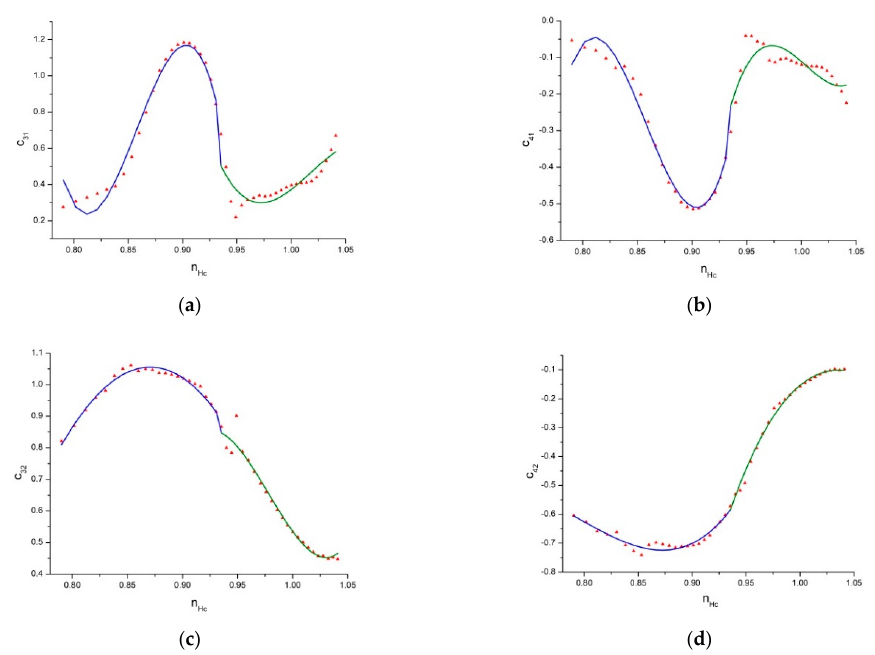
Figure 10. Matrix elements in the system matrix C : ( a ) c 31 ; ( b ) c 41 ; ( c ) c 32 ; ( d ) c 42 .